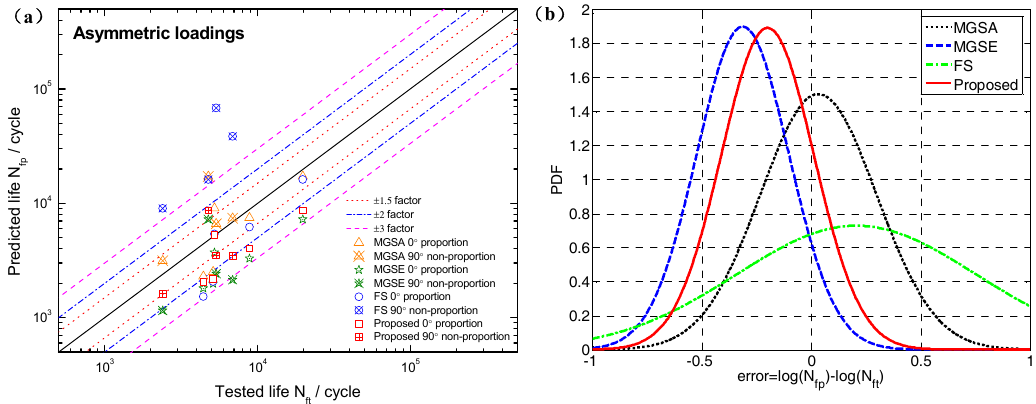
Figure 9. ( a ) Comparison between model predictions and tested fatigue lives of TC4 under asymmetric loading and ( b ) probability density functions of model prediction errors.